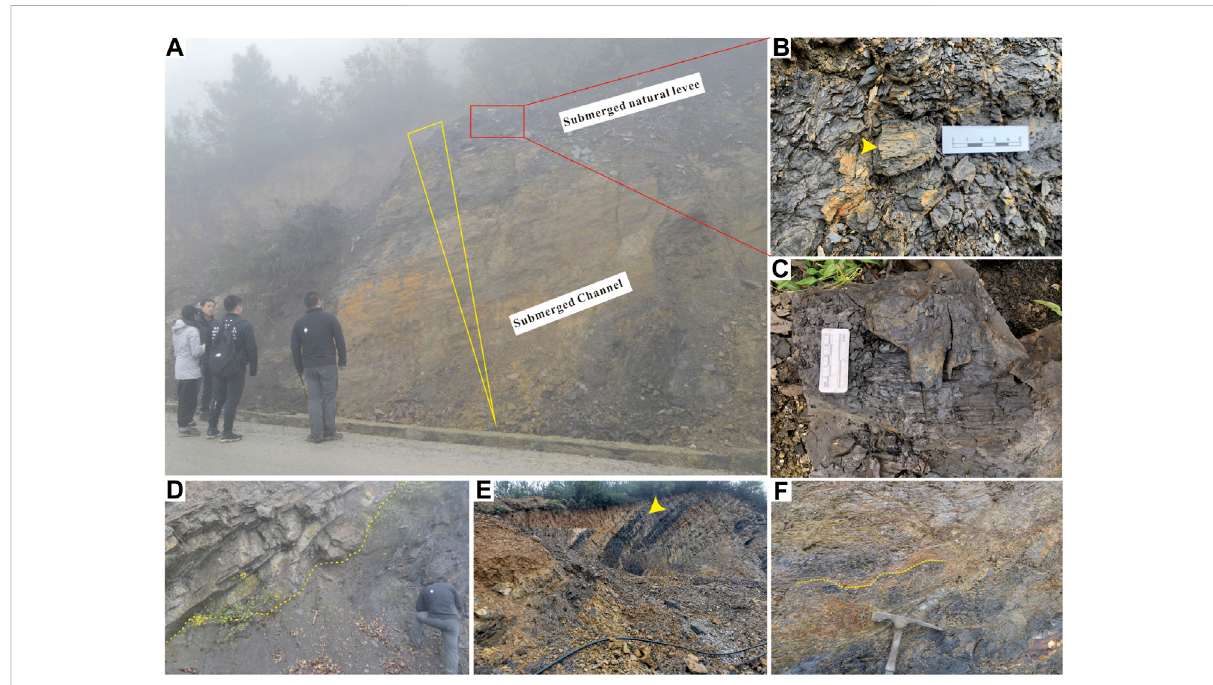
FIGURE 9 Facies association 3 in section YGX. (A) Finning upwards sequence in a submerged fl uvial environment. (B) Lithofacies Mp (Phytophoric mudstone) with abundant lepidophyte leaves, in a submerged natural levee setting. (C) lepidophyte trunk, fl oodplain setting. (D) The boundary (yellow dashed line) of lithofacies Mp and lithofacies Ss (structureless sandstones), an erosional base together with sandstones structure suggest a submerged distributary channel deposit. (E) The sheet sandstone was penetrated by fi nger-like mudstones, in a distal delta front setting. (F) Lithofacies Ms (sigmoidal mudstones) with a dip direction towards the lagoonal environment (yellow dashed line), in a prodelta